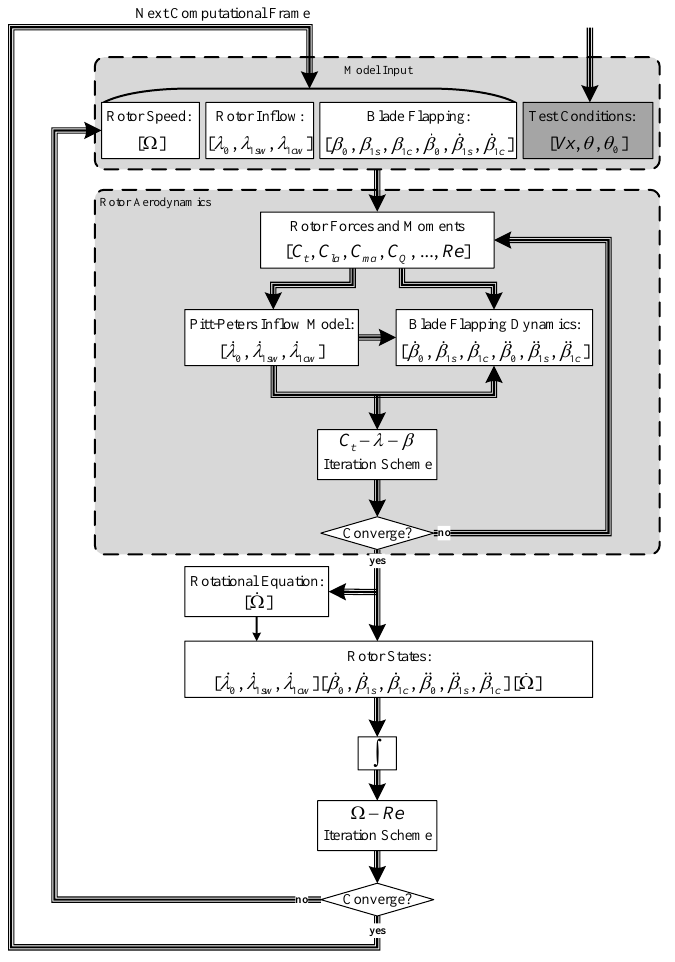
Figure 1. Rotor aerodynamics computational model.